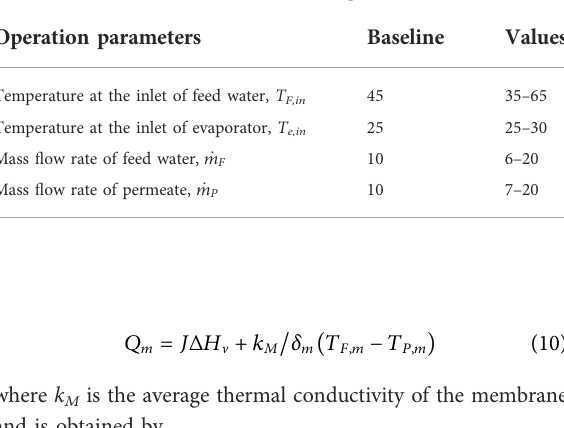
TABLE 4 Simulation conditions for the integrated